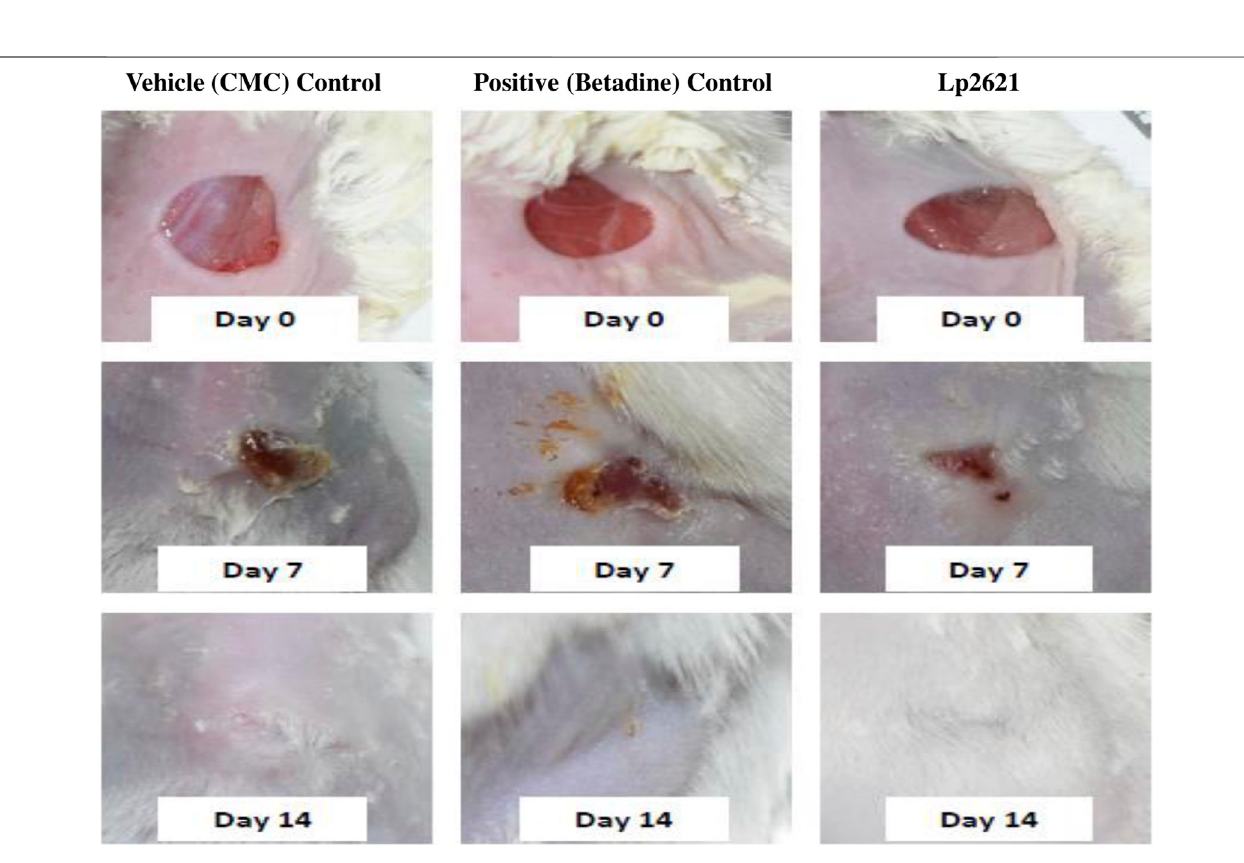
Frontiers in Pharmacology |